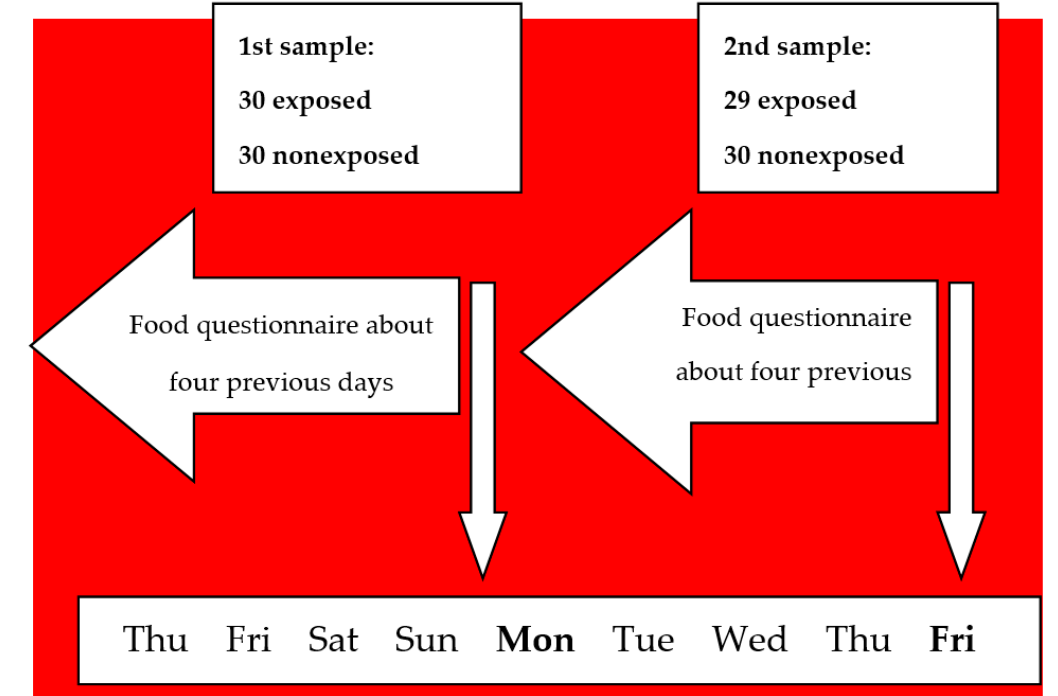
Figure 1. Scheme of the days investigated for food